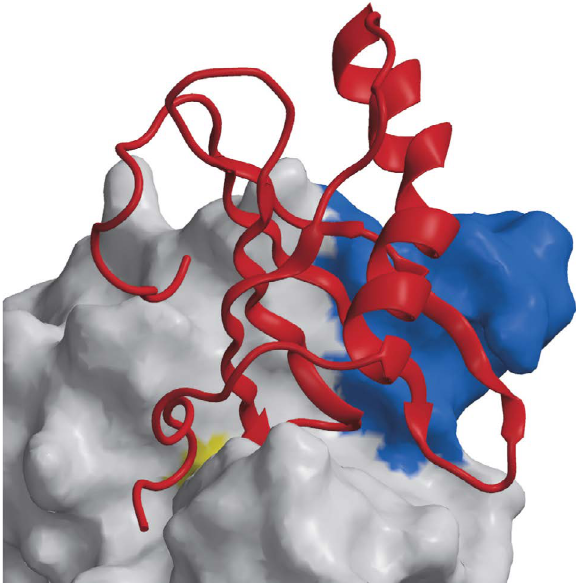
Figure 5. Cathepsin B - stefin A complex 133 (3K9M). Cathepsin B is shown as white surface with the catalytic Cys area yellow and oc- cluding loop displaced from the active site cleft in blue. Stefin A is shown as red